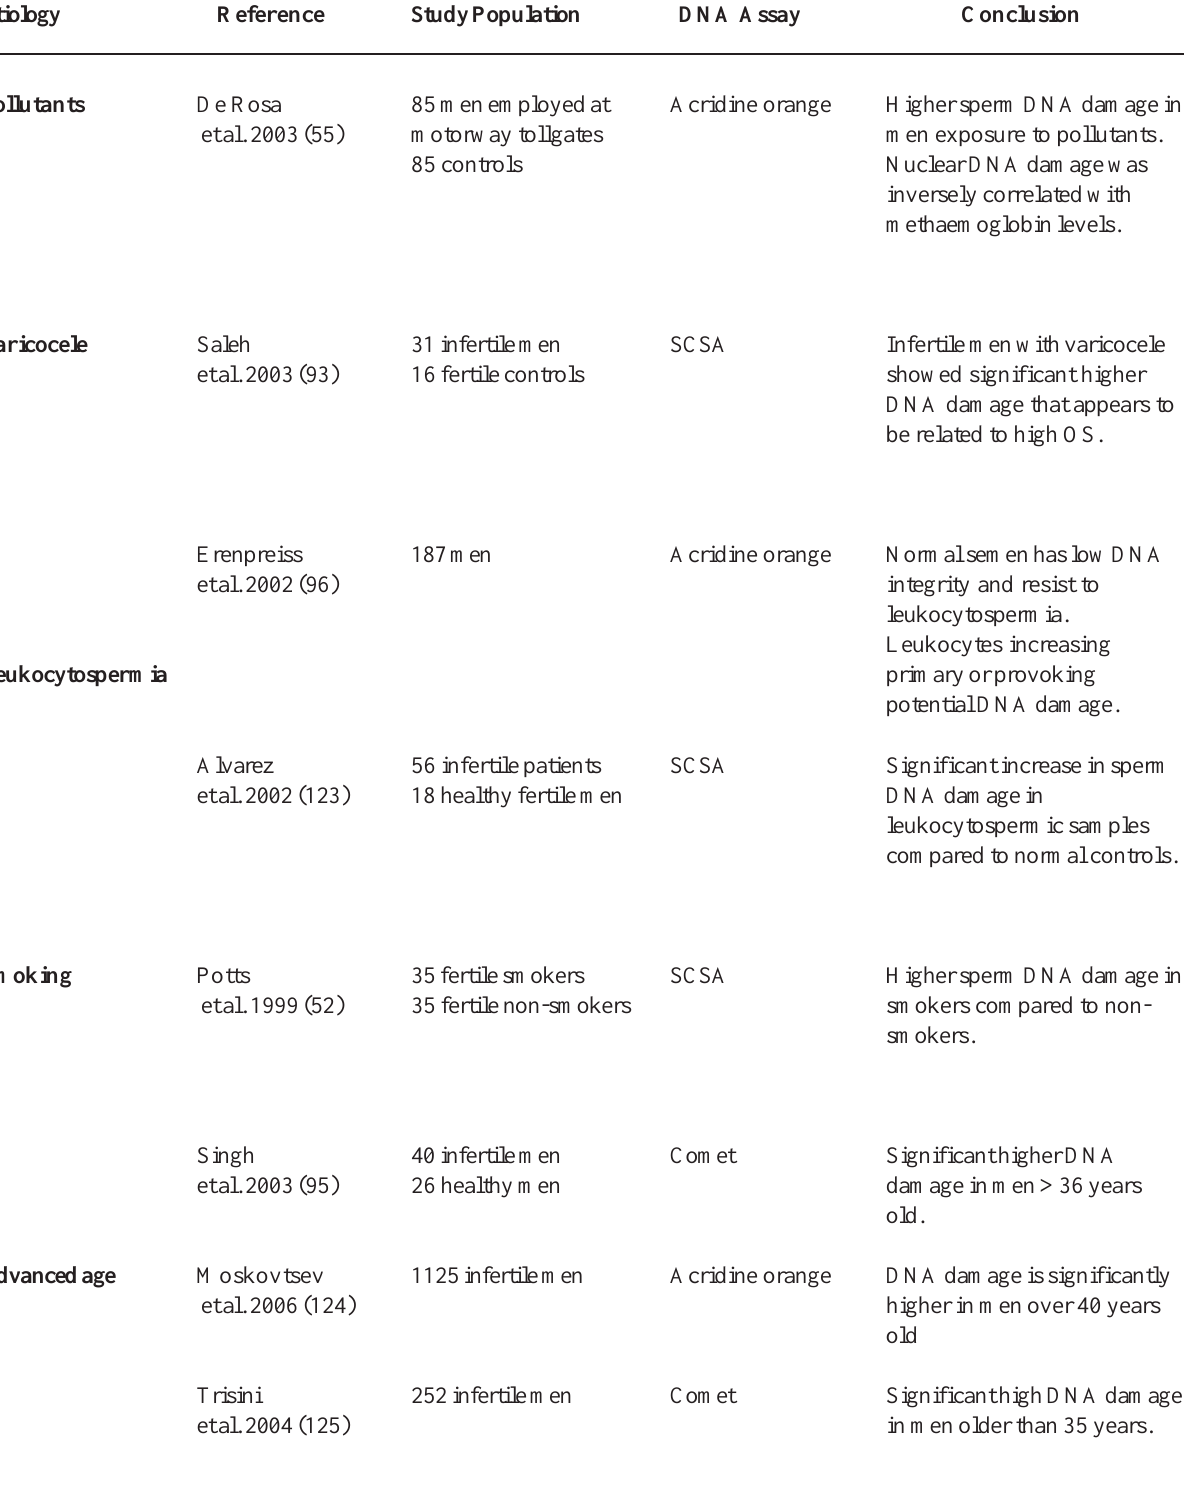
Table 1 – Etiological factors associated with increased human sperm DNA